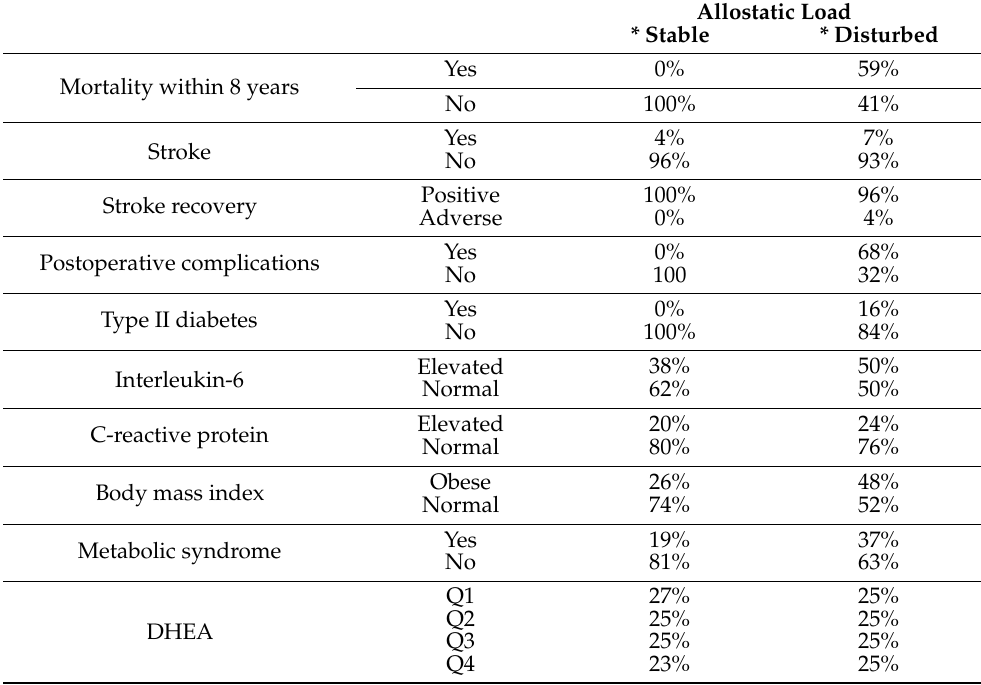
Table 3. Probabilities of BNN when an outcome is observed, including associated medical conditions in elderly populations. These conditions being intermediate to the eventual overall outcome, being defined as “allostatic load” specified for elderly (>60 years of age) and statistically robust (due to the strictly applied criteria in Bayesian